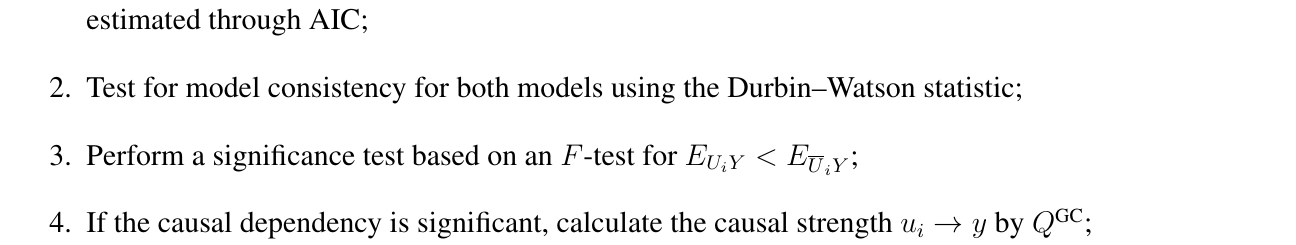
Algorithm 2: Algorithm based on Granger